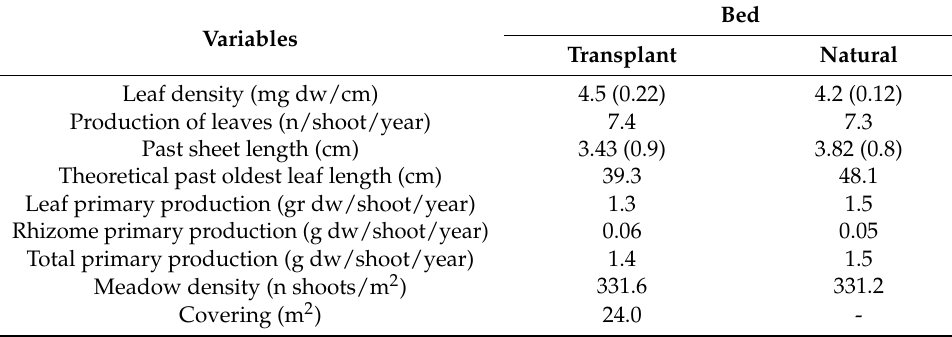
Table 2. Primary production values estimated in two